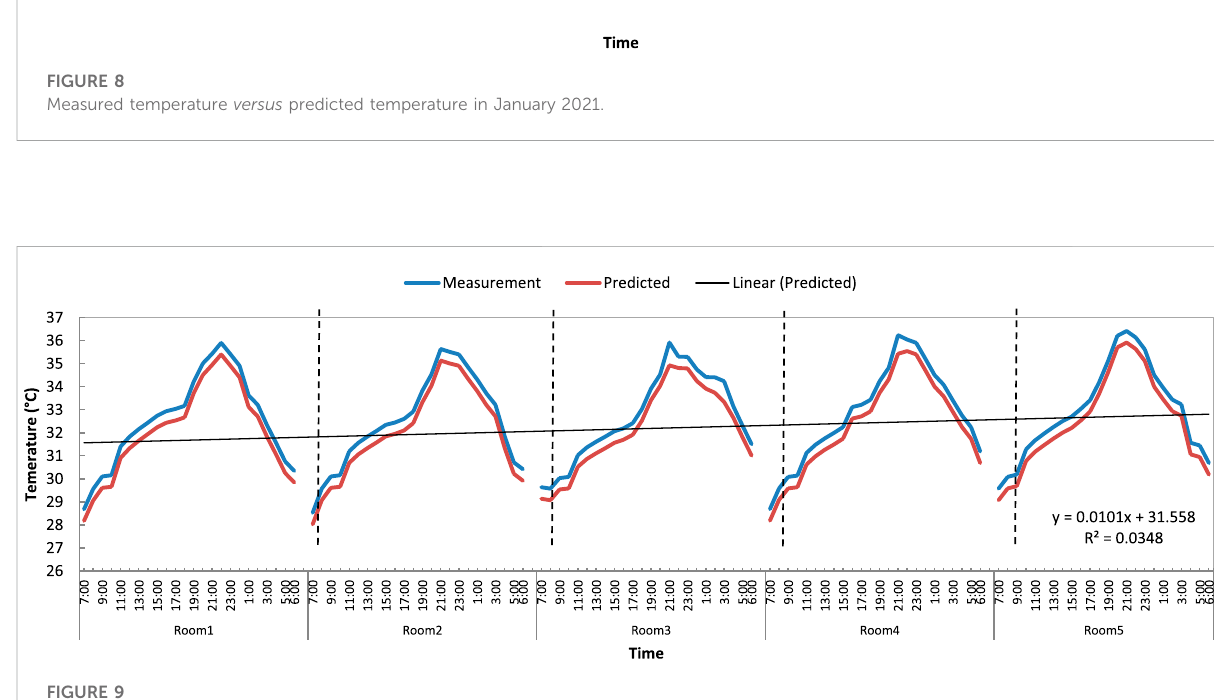
FIGURE 9 Measured temperature versus predicted temperature in June